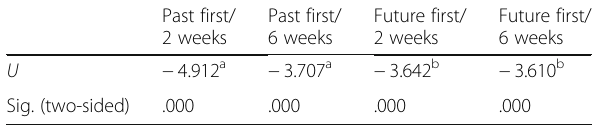
Table 2 Wilcoxon test for before and after regret scores per condition